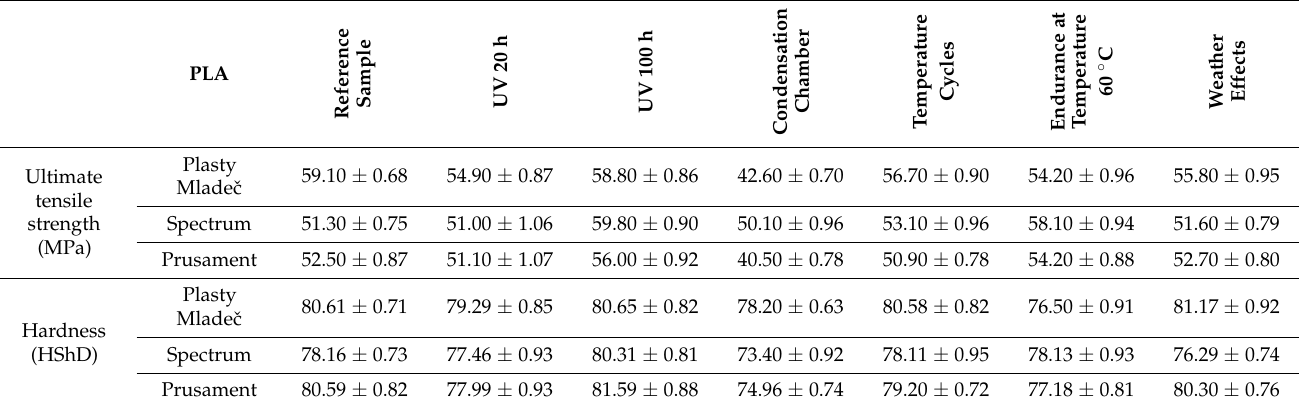
Table 5. Measured results—PLA material.